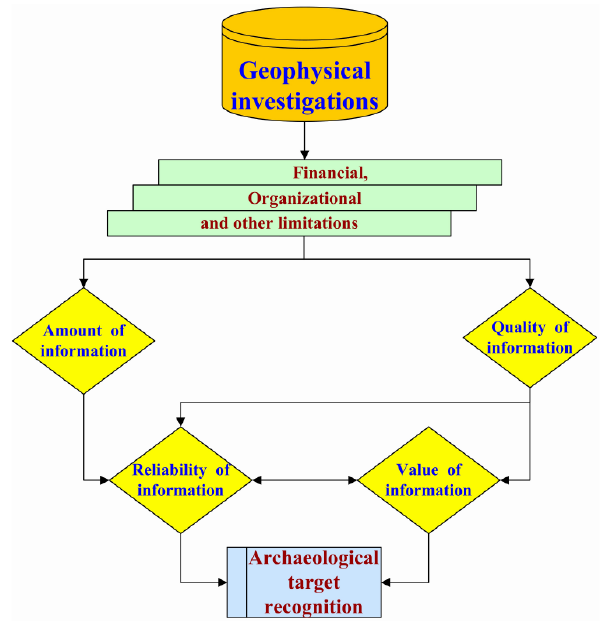
Fig. 2. A scheme of archaeogeophysical target recognition with elements of information theory (on the basis of Eppelbaum et al. (2003), with